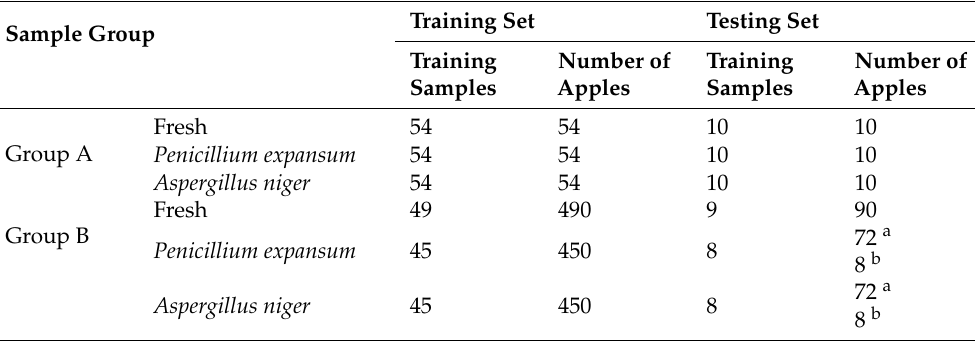
Table 2. Experimental apple information of different sample